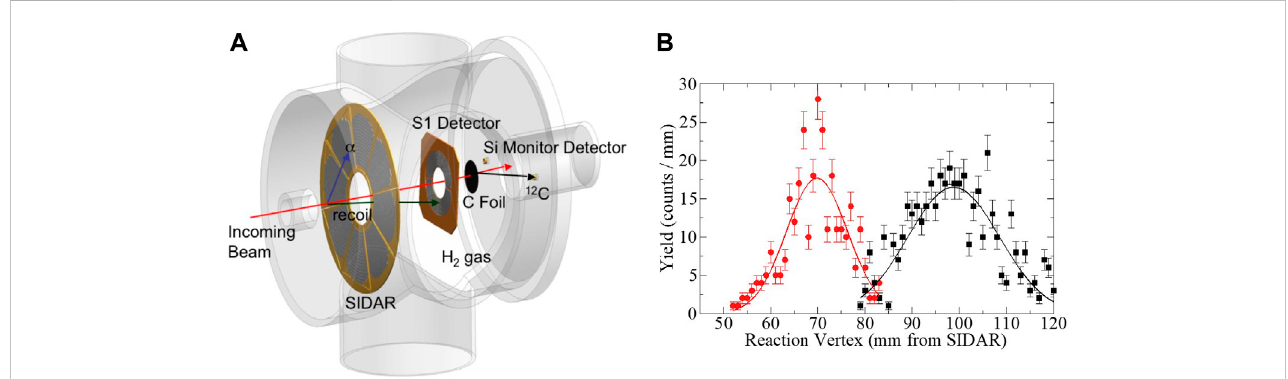
FIGURE 4 (A) Experimentalsetupusedtomeasurethe 31 P( p , α ) 28 Sireaction.The 31 Pbeambombardedadifferentially-pumpedhydrogencontainingtargetchamber inwhichvarioussilicondetectorswereplaced[22]. (B) Thevertexofthe( p , α )reactionscouldbereconstructedfromreactionkinematics.Thevertexmovedas expected when the beam energy was changed.